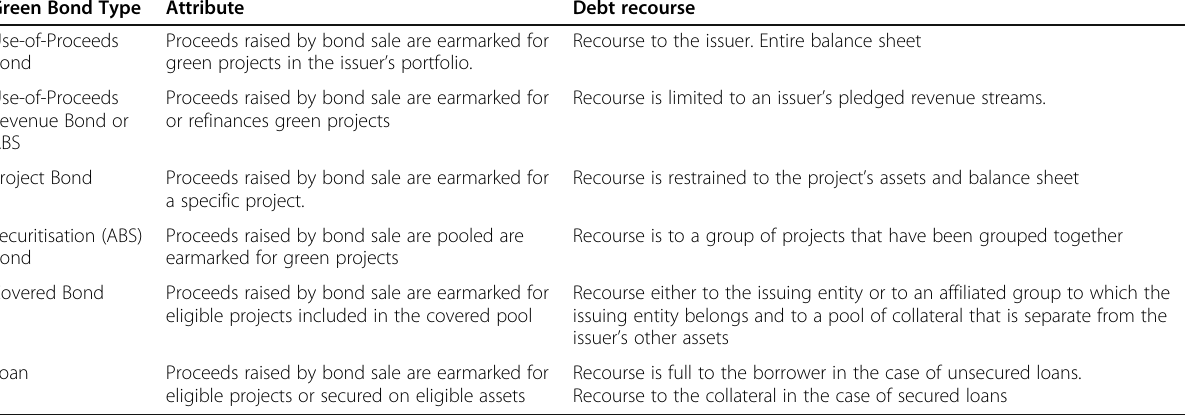
Table 2 Typology of Green Bonds Green Bond Type